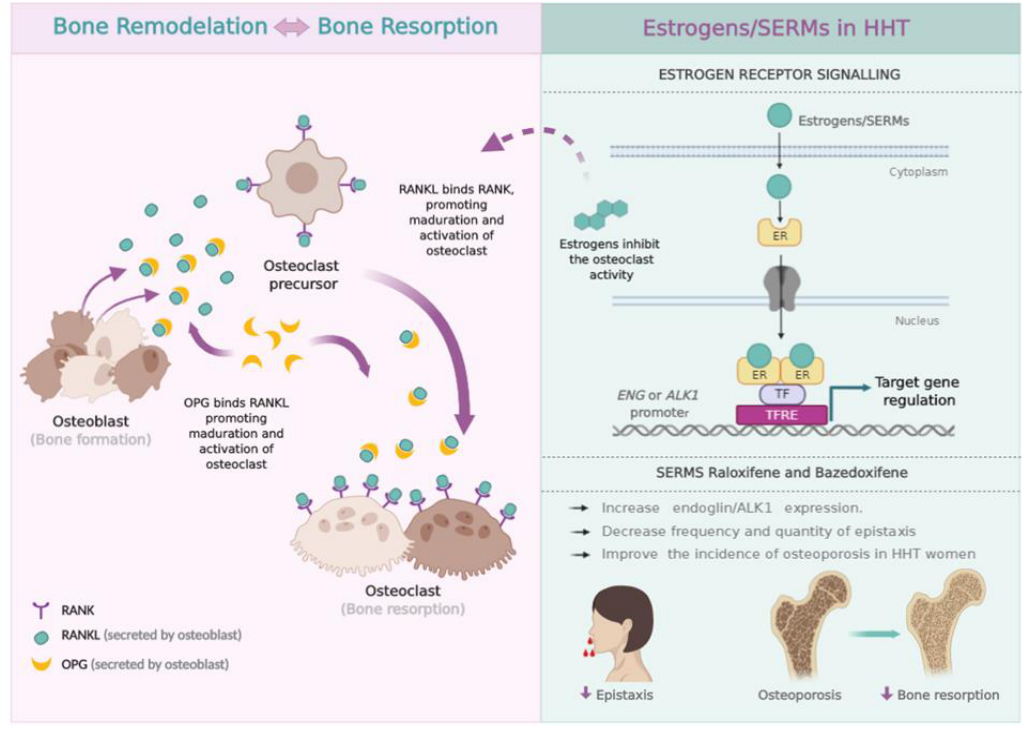
Figure 2. Scheme of Bone formation vs. Bone resorption ( left ). Bone remodeling is promoted by the activity of osteoclasts and osteoblasts. RANKL is a protein expressed by osteoblasts which, upon binding to its RANK receptor on the cell surface of osteoclasts and their precursors, causes RANK to stimulate and promote the adhesion of osteoclasts to bone, thus activating their function and preventing apoptosis. OPG is synthesized by the osteoblasts and acts as a decoy receptor, preventing the binding of RANKL to RANK, therefore decreasing the activity of the osteoclast and its survival [52]. For this reason, for years post-menopausal patients with diagnosed osteoporosis have been receiving estrogenic treatment, which, while correcting this imbalance in bone remodeling, also reduces the activity of the osteoclast and activates the expression of OPG. This is also capable of reducing the epistaxis of these patients [25,33,53,54]. Scheme of Estrogen Receptor (ER) signaling ( right ). Mechanism of action of ER on EC, in the case of the SERMs raloxifene and bazedoxifene. Upon ligand binding, the ER dimer interacts with different transcription factors (TF), promoting gene expression by binding to the TFRE (Transcription Factor Regulatory Element) in the promoter of its target genes . The expression of endoglin and ALK1 increases as a result of the interaction of the ER with Sp1, an essential factor for the expression of both genes. In women, SERMs promote a decrease in the frequency and amount of epistaxis, normalizing the nasal vasculature with concomitant improvement in osteoporosis [25,26].